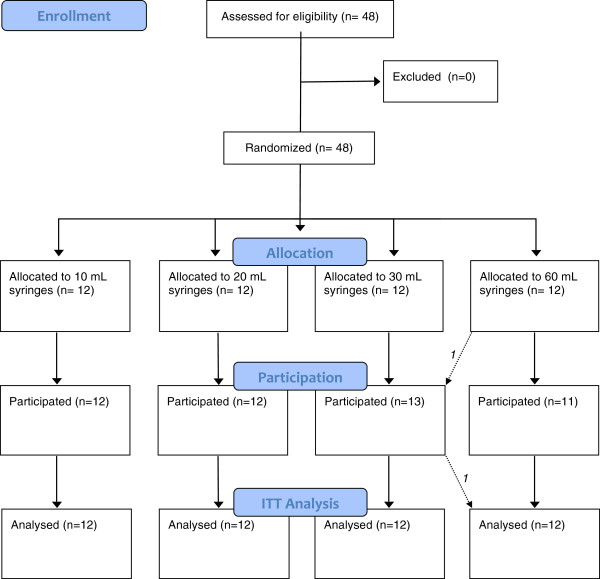
The Pediatric Fast Fluid Trial flow diagram. No participants were excluded from initial 48 subject recruitment. All subjects completed protocol to analysis. Initial allocation called for 1:1:1:1 syringe size distribution, however one subject was mistakenly allocated to participate in the 30 mL group from the 60 mL group. This same subject was analysed as per protocol in the 60 mL group after per protocol analysis showed no change in primary outcome.